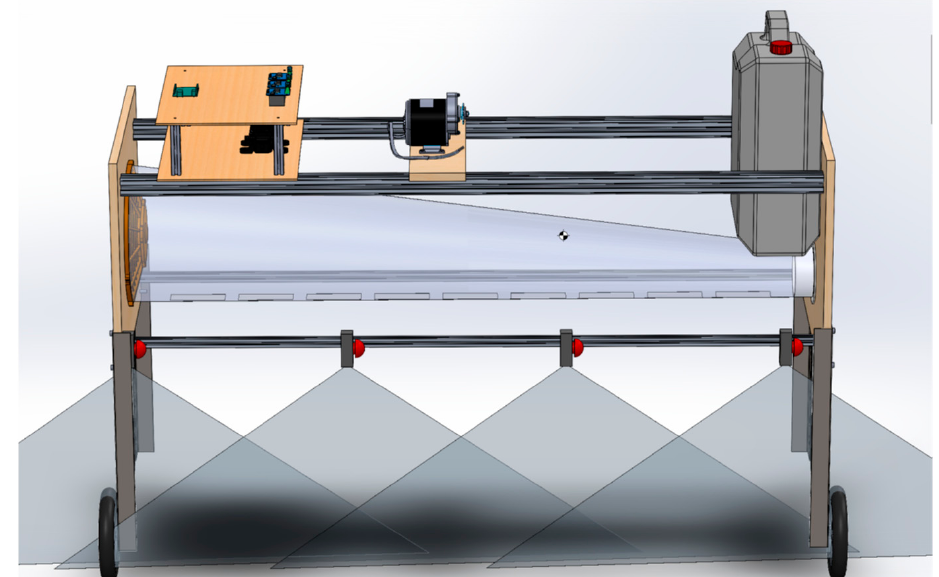
Figure 1. CAD model of the prototype.